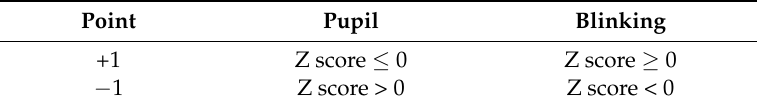
Table 1. Scoring criteria engagement index based on Z